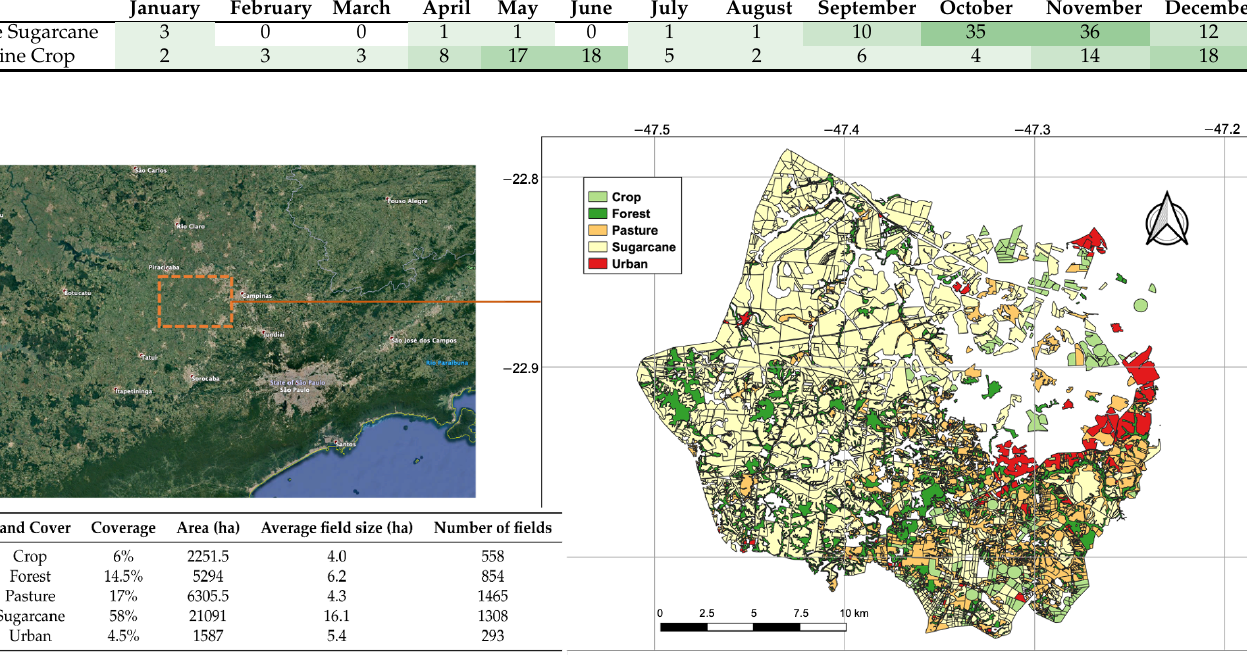
Figure 1. Location of the study area ( top left ); spatial map of the reference LULC ( right ); and characteristics of the LULC based on the collected ground truth data ( bottom left